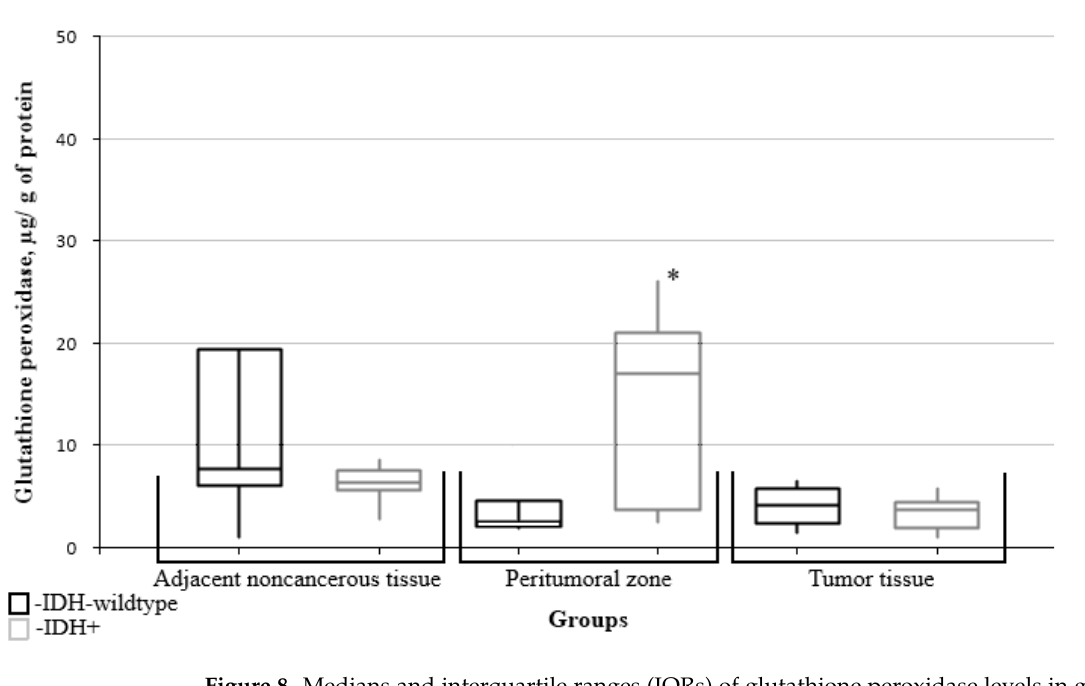
Figure 7. Medians and interquartile ranges (IQRs) of reduced glutathione levels in glial tumor tissues as a function of the IDH1 isocitrate dehydrogenase isoenzyme gene mutation. There are significant differences between the tumor tissue reduced glutathione levels (*—Mann-Whitney U-test p = 0.011) for groups with Wild type IDH1 and those expressing the IDH1 mutation. The levels of glutathione peroxidase in the peritumoral zone tissue of patients with gliomas and the IDH1 mutation were significantly higher than in the wild-type IDH1 group (Figure 8).